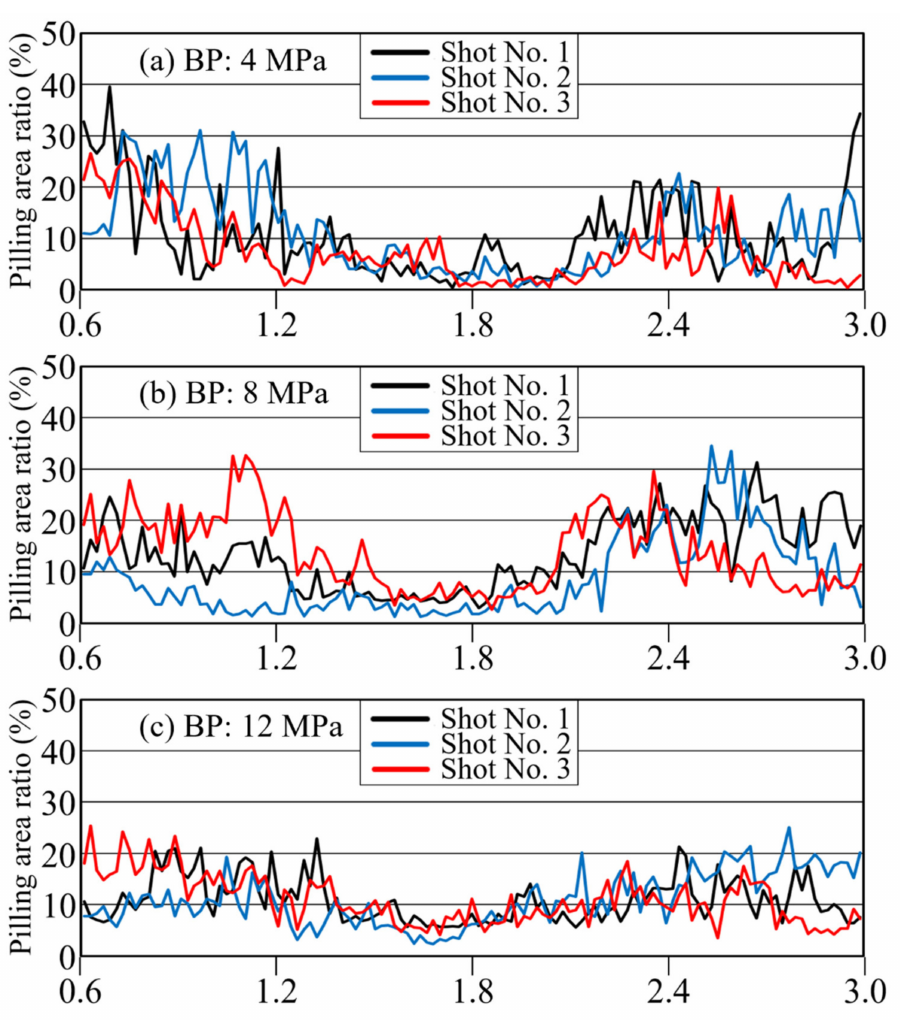
Figure 12. Change curves with time of pilling area ratio under BP of ( a ) 4 MPa, ( b ) 8 MPa, and ( c ) 12 MPa